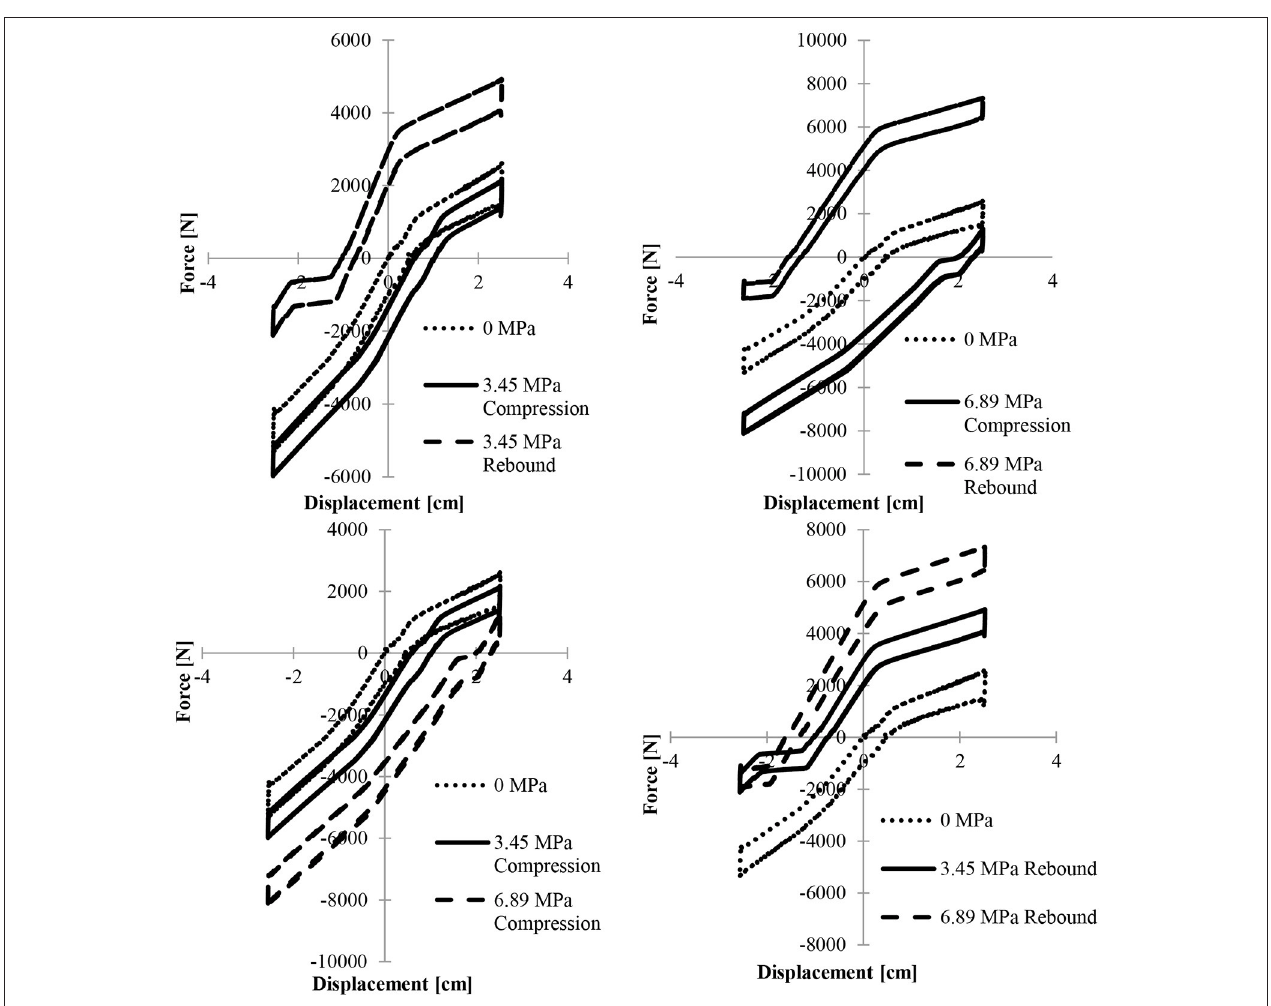
FIGURE 12 | (Top Left) Force displacement plot for quasistatic preloading in compression and rebound at 3.5 MPa compared to 0 MPa initial pressures illustrates the developing multi-linearity. (Top Right) Force displacement plot for quasistatic preloading in compression and rebound at 6.89 MPa. (Bottom Left) Comparison of quasistatic force versus displacement over the range of 0 to 6.89 MPa preloading in compression illustrates the shift in the multi-linearity. (Bottom Right) Comparison of quasistatic force versus displacement over the range of 0 to 6.89 MPa.